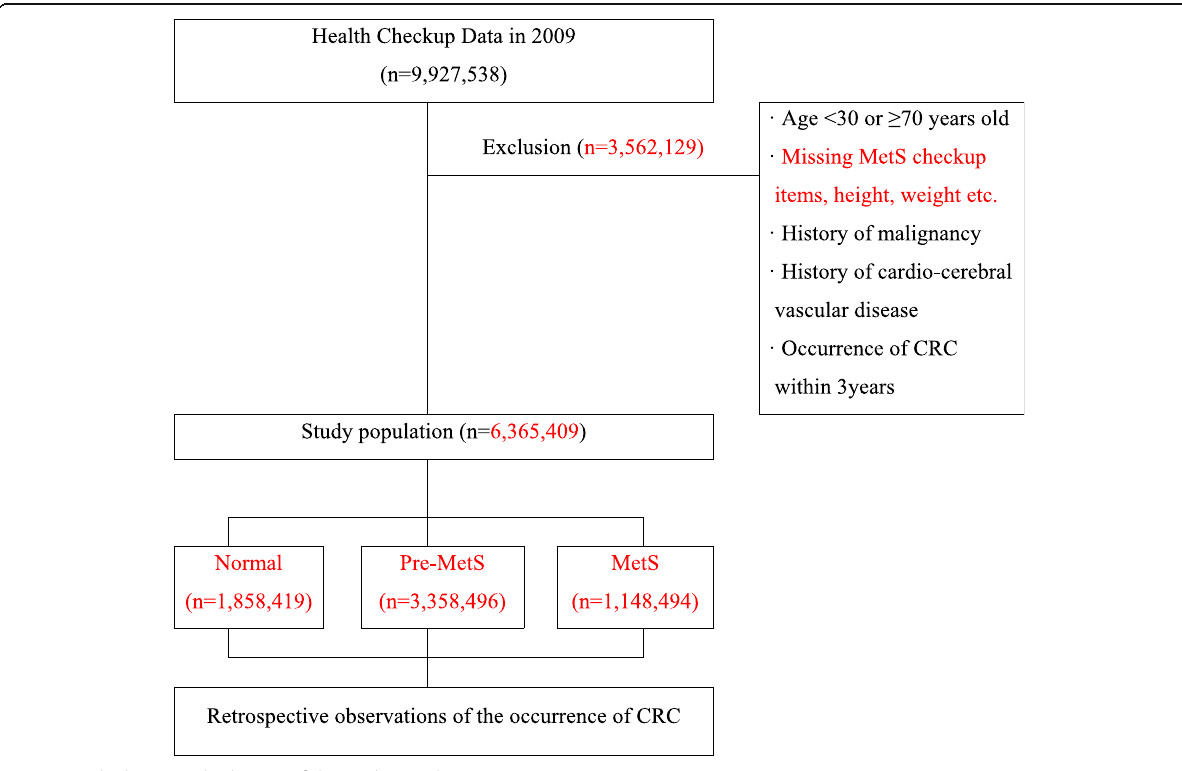
Fig. 1 Study design and selection of the study